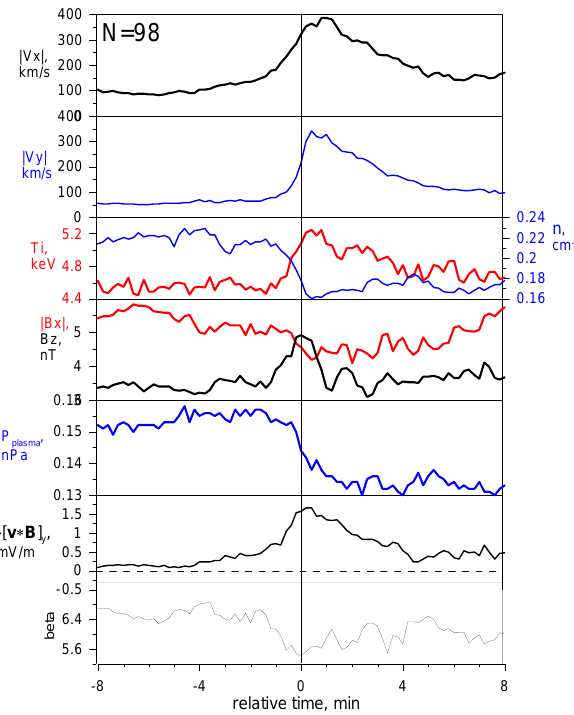
Figure 5 Average velocity, magnetic field and plasma parameter Fig. 5. Average velocity, magnetic field and plasma parameter variations for |Vy|>400 km/s events, resulting from the superposed epoch analysis. Reference time is defined as the start of sharp |V y | variations for | V y | > 400km/s events, resulting from the superposed growth above 200 km/s. epoch analysis. Reference time is defined as the start of sharp | V y | growth above 200km/s.